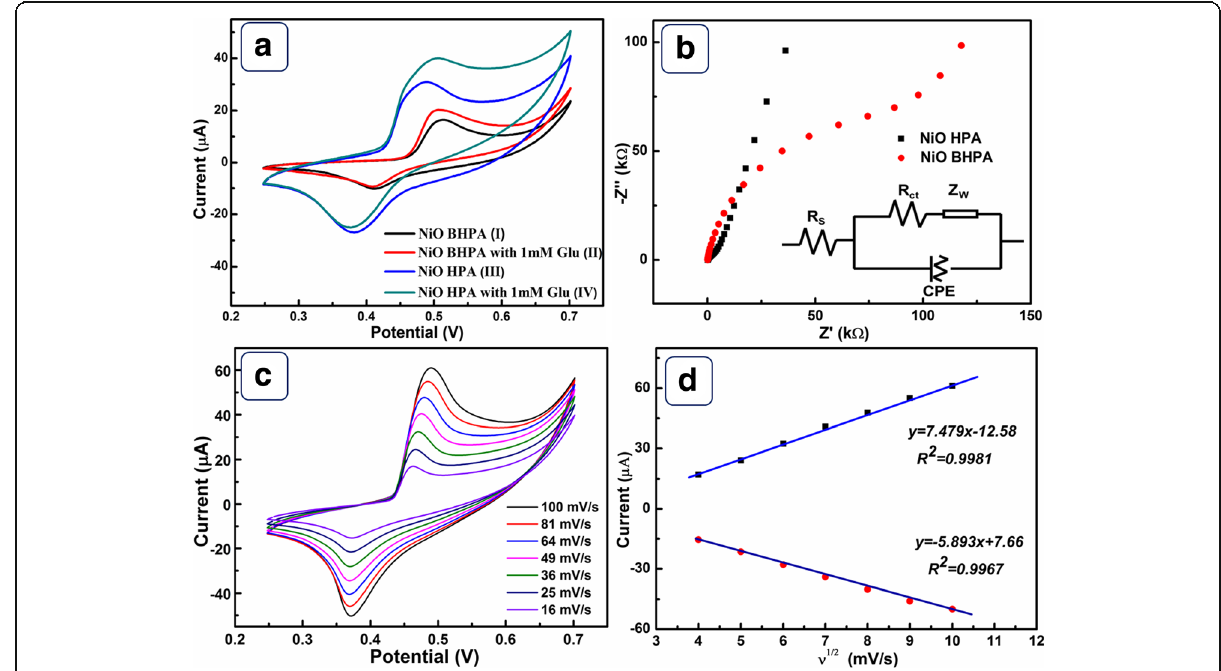
Fig. 5 a CVs of NiO BHPA (I, II) and NiO HPA (III, IV) electrode with (II, IV) and without (I, III) the presence of 1 mM glucose in 0.1 M NaOH at scan rate 50 mV/s. b Nyquist diagrams EIS and equivalent circuit of NiO HPA and NiO BHPA in 0.1 M NaOH solution. c CVs of NiO HPA electrode at various scan rates in 0.1 M NaOH with 1 mM glucose and d the relationship between peak current and square root of scan